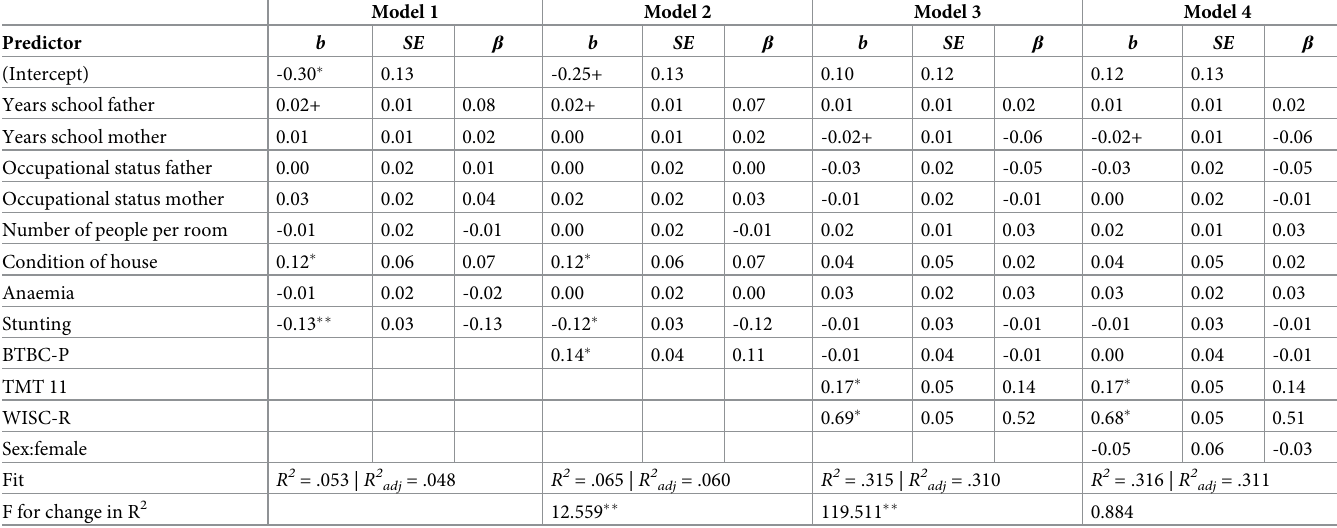
Table 5. Regression results for performance on the Trail Making Test at age 17 years predicted by early childhood risk factors (age 3 years) as well as cognitive func- tioning at ages 3 and 11 years and sex.